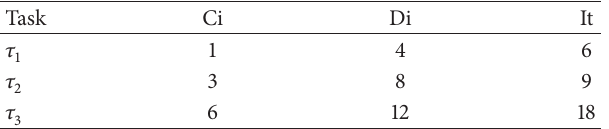
Table 1: Example tasks set.